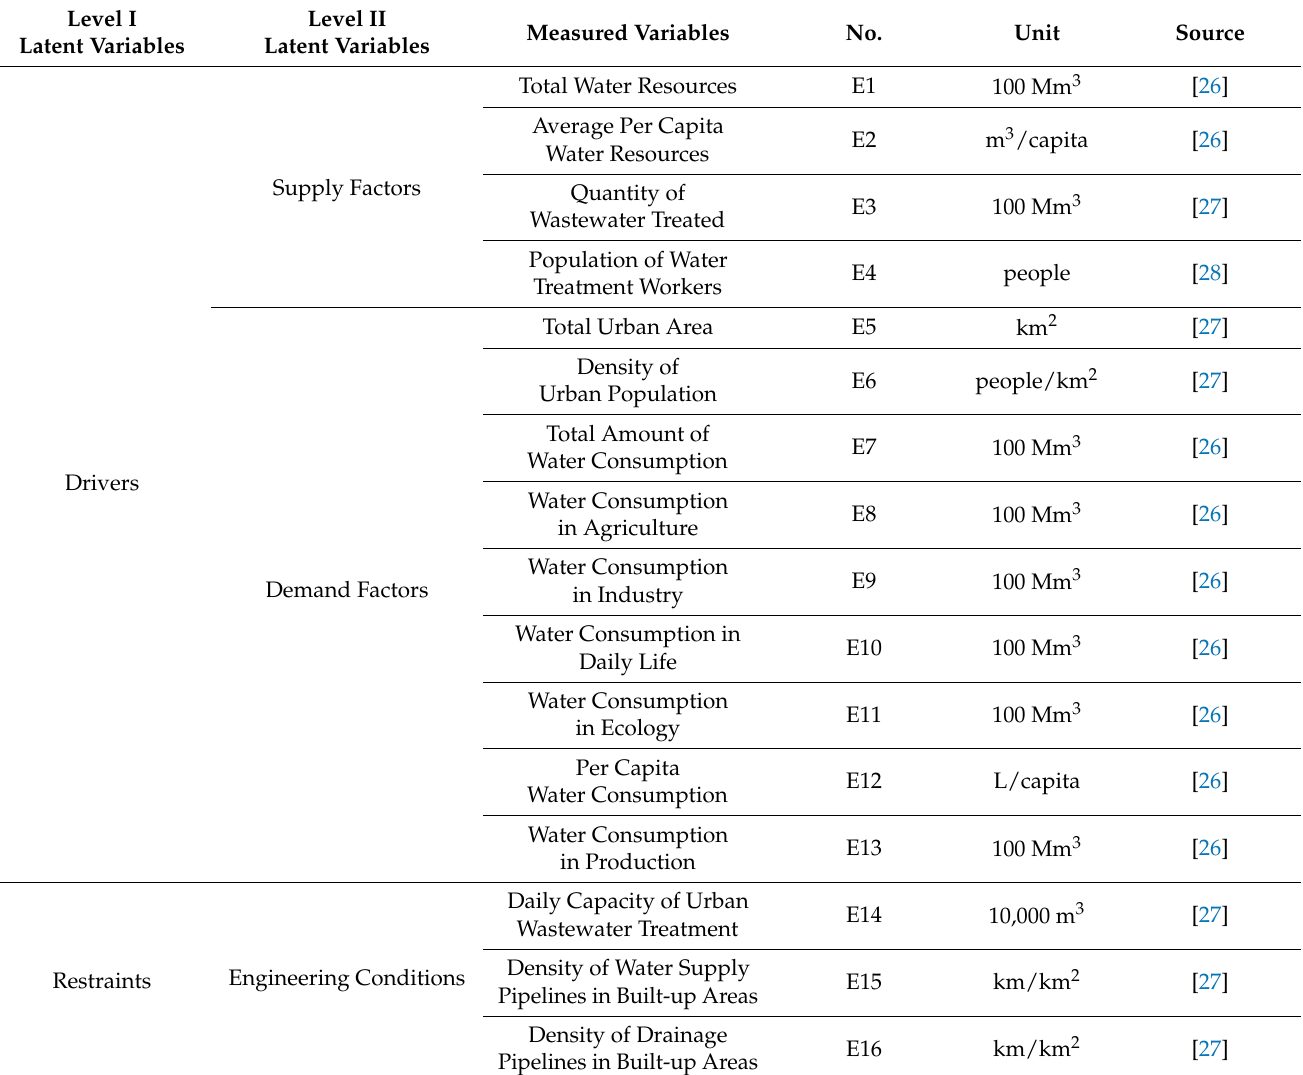
Table 1. Measurement model for reclaimed water